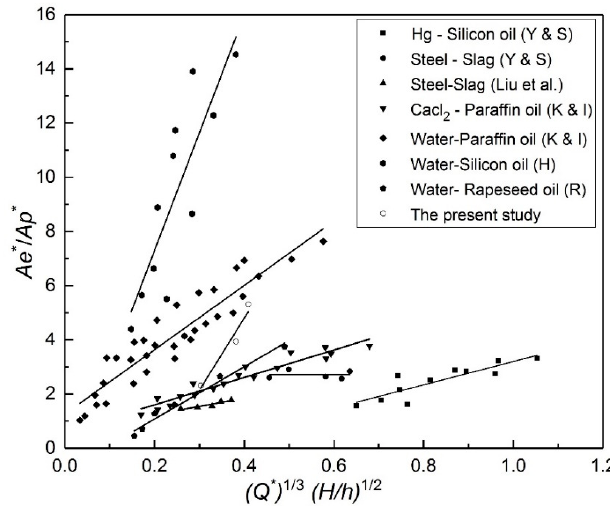
Figure 8. Comparison of non-dimensional open-eye area ratio with the literature (K & I: Krishnapisharody and Irons [6]; Yonezawa and Schwerdtfeger [5]; Han et al. [37]; E. Ramasetti et al.